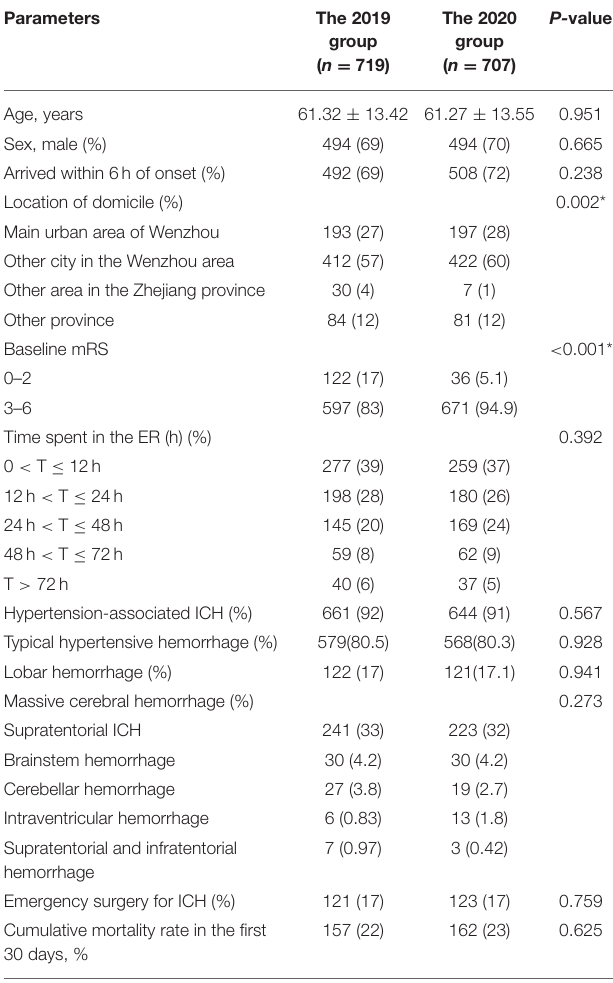
TABLE 1 | Clinical characteristics of the patients with ICH diagnosed between January and June 2019 and January and June 2020.